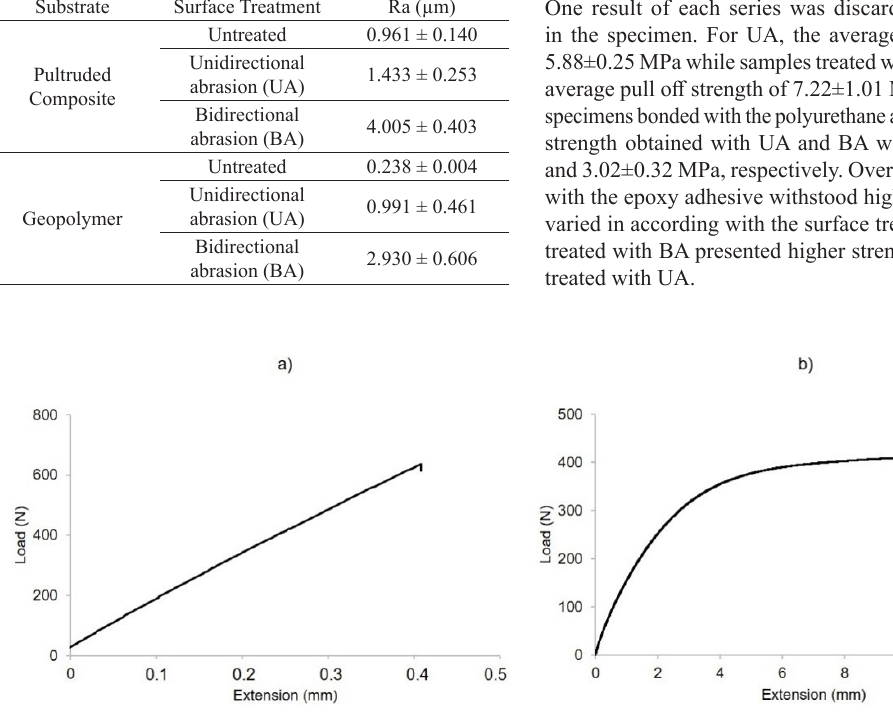
Figure 4. Representative load-extension curves of the (a) epoxy and (b) polyurethane adhesive.